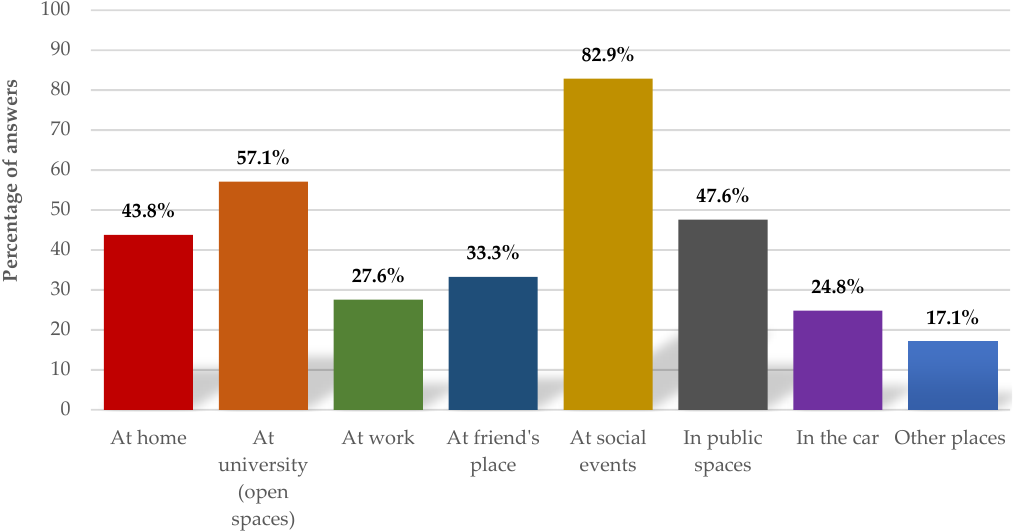
Figure 1. Tobacco consumption places.